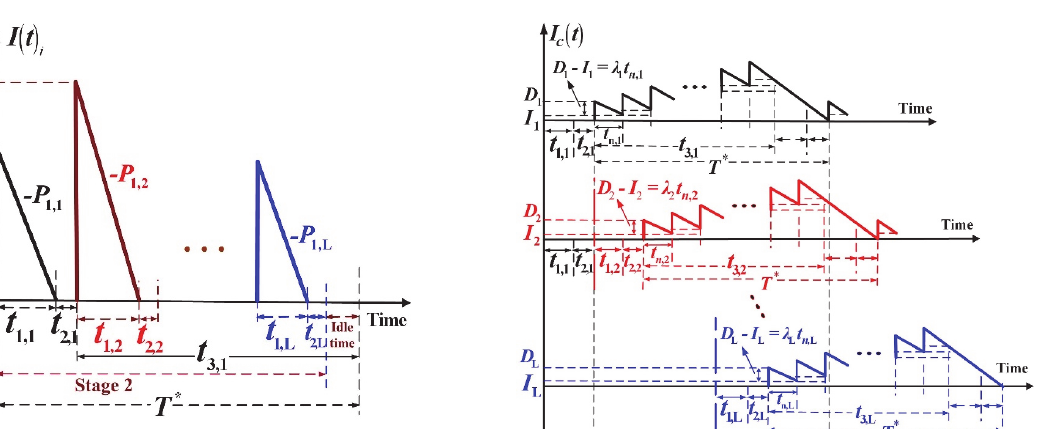
Fig. 4. On-hand inventory level of common parts waiting to be fabricated into customized end products in stage 2 of the proposed study